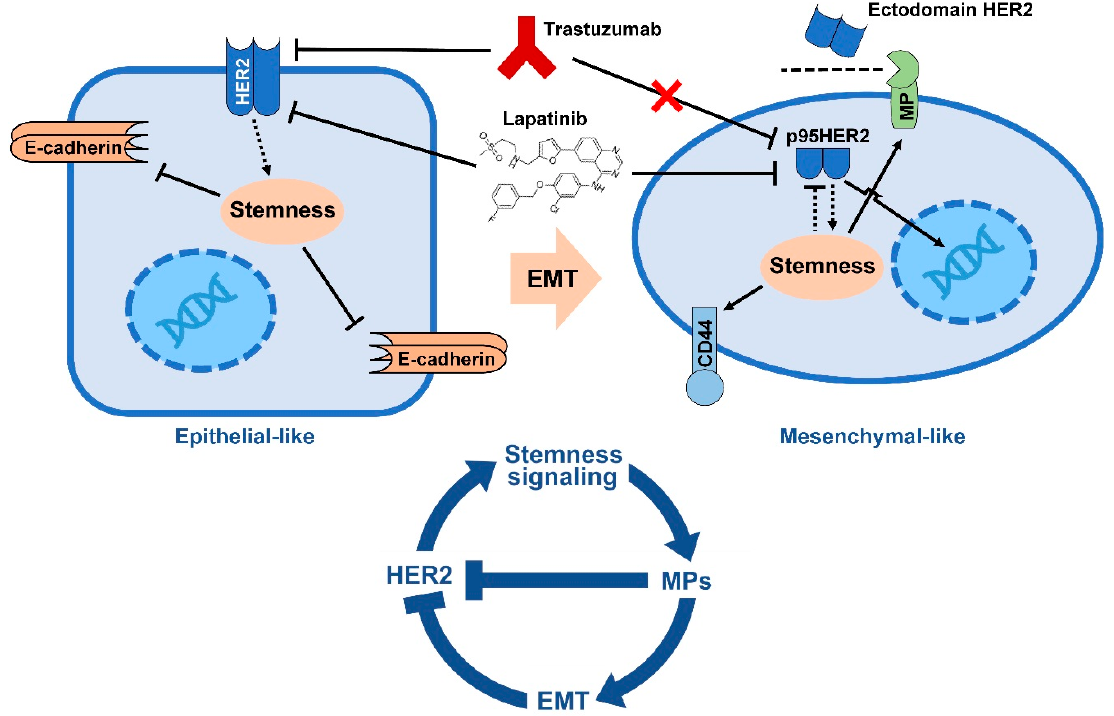
Figure 2. Negative feedback relationship between HER2 and BC stemness leading to trastuzumab resistance. HER2+ BC cell responds to trastuzumab and lapatinib in epithelial-like context. In this context, HER2 increases expression of stemness markers resulting in down-regulation of epithelial marker E-cadherin and up-regulation of EMT phenotype including MPs. In mesenchymal context MPs cleave HER2 receptor from juxtamembrane of the receptor that results HER2 shedding and expression of p95HER2. p95HER2 maintain its kinase activity and is able to activate AKT and MAPK pathways and to translocate to the nucleus where acts as transcription co-factor. Mesenchymal-like p95HER2+ cell respond to lapatinib but is resistant to trastuzumab.